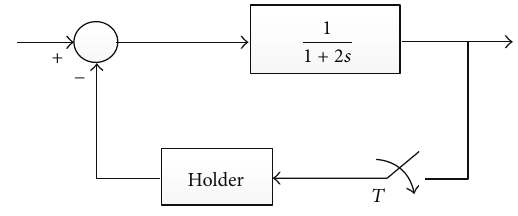
Figure 8: A continuous system with a holder.